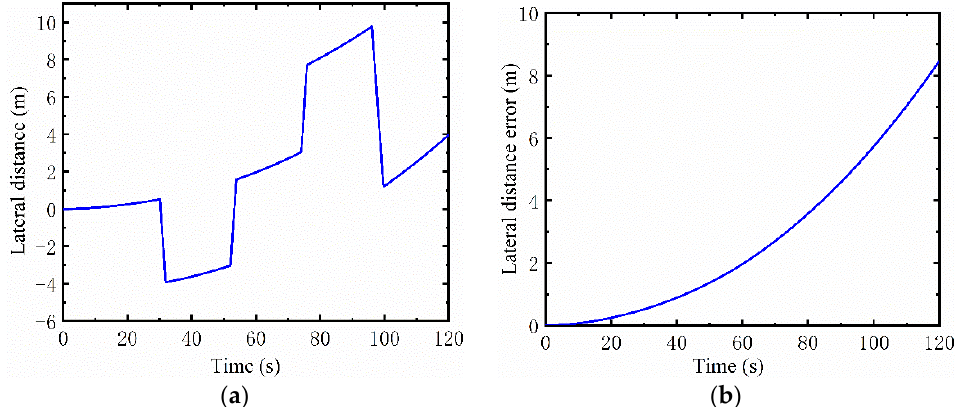
Figure 11. Inertial guidance solution information: ( a ) Lateral distance variation of the inertial guidance solution; ( b ) Lateral distance error of inertial guidance solution.